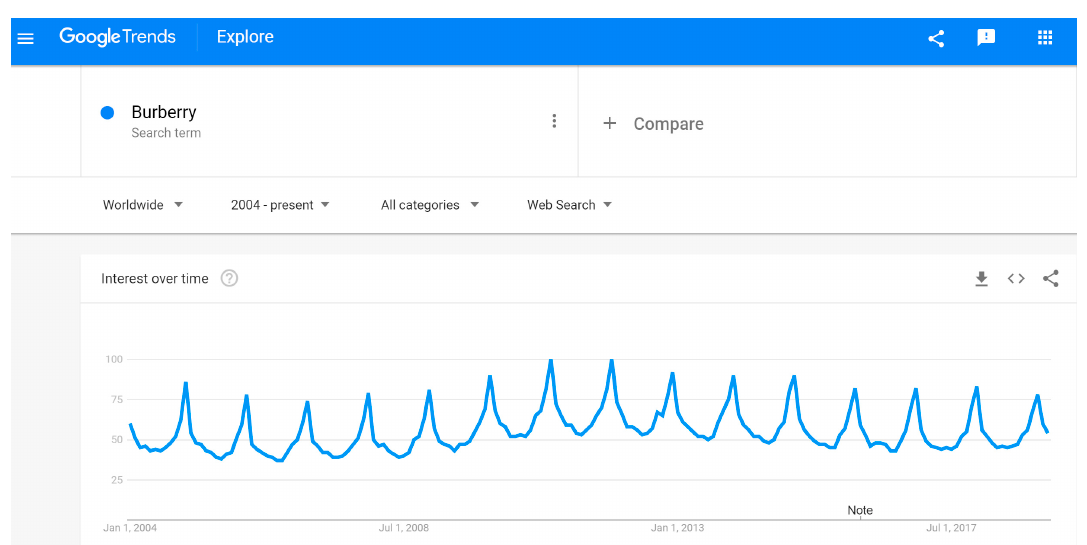
Figure 9. Google Trends for “Burberry” (January 2014–February 2019). (Data Source: Google Trends, (10 February 2019).